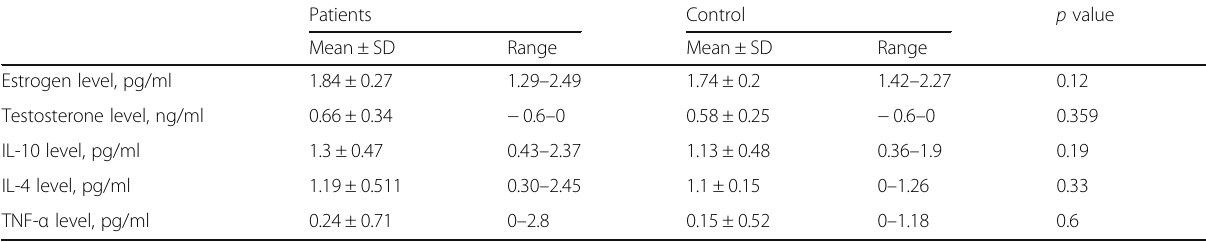
Table 1 Comparison between patients and control subjects as regards hormonal profile and cytokine level